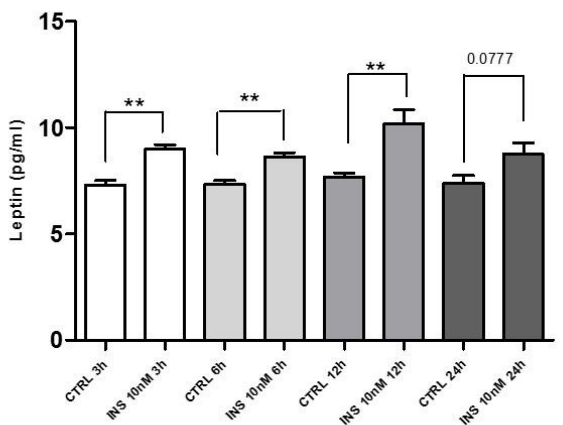
Figure 7. PBMCs were isolated from healthy donors’ buffy coat, washed twice in PBS, and then treated with high insulin levels (10 nM) for 3 h, 6 h, 12 h, and 24 h. Cells supernatant were used to evaluate leptin secretion, which was compared to the untreated samples. A significant increase in leptin secretion was detected after 3 h, 6 h, and 12 h of insulin treatment, but a not significant increase with Wilcoxon–Mann–Whitney U Test (** p < 0.005). CTRL: control; INS: